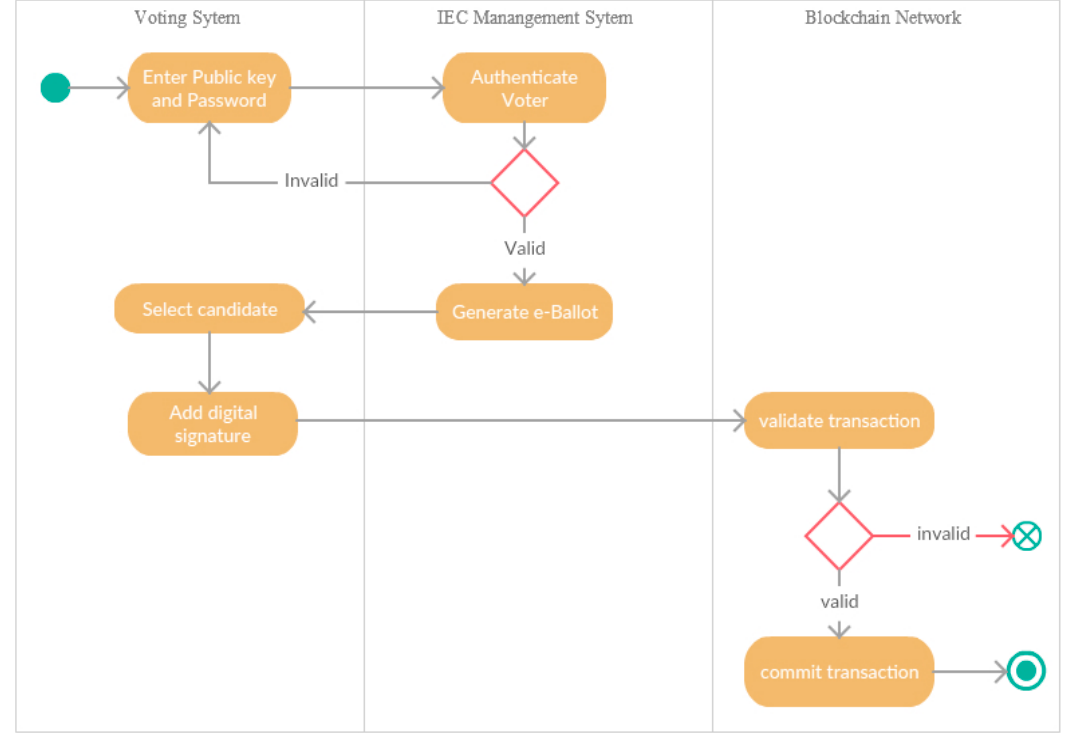
Informatics 2020 , 7 , x FOR PEER REVIEW Figure 3. Process View—UML activity diagram of BANES. Figure 3. Process View—UML activity diagram of BANES.